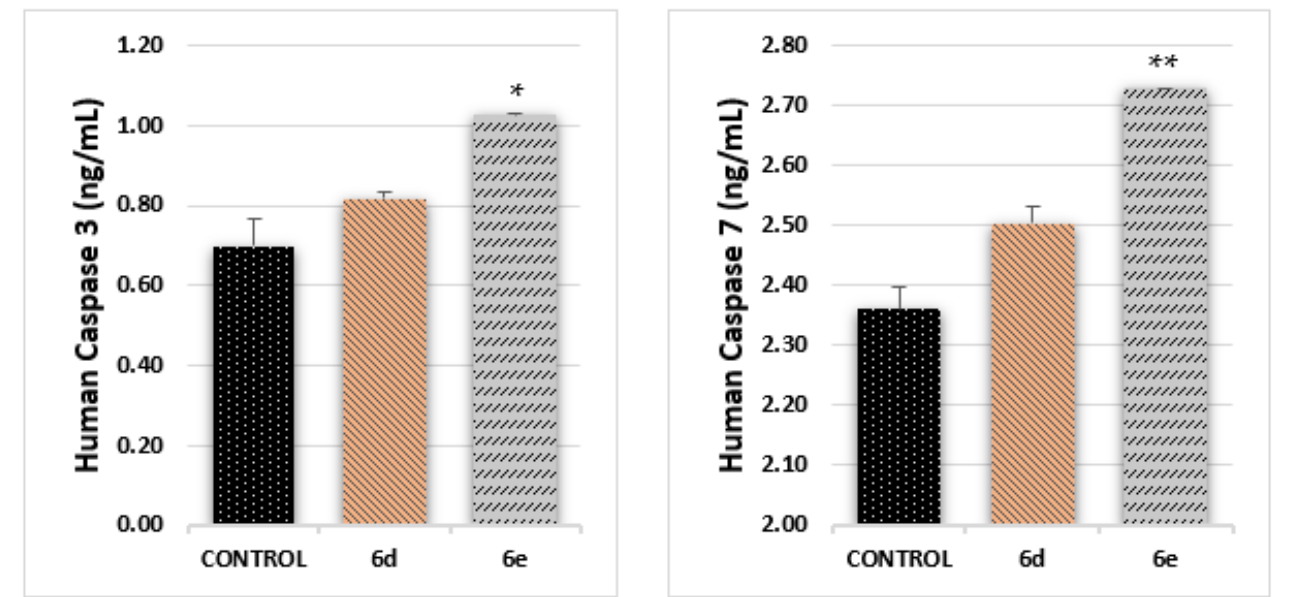
Figure 10. Effect of 6d and 6e hybrids on apoptotic biomarker expression in SW620 cells. Results are the mean ± SE of two independent experiments. p -values less than 0.05 were considered statistically significant (* p < 0.05; ** p < 0.01).